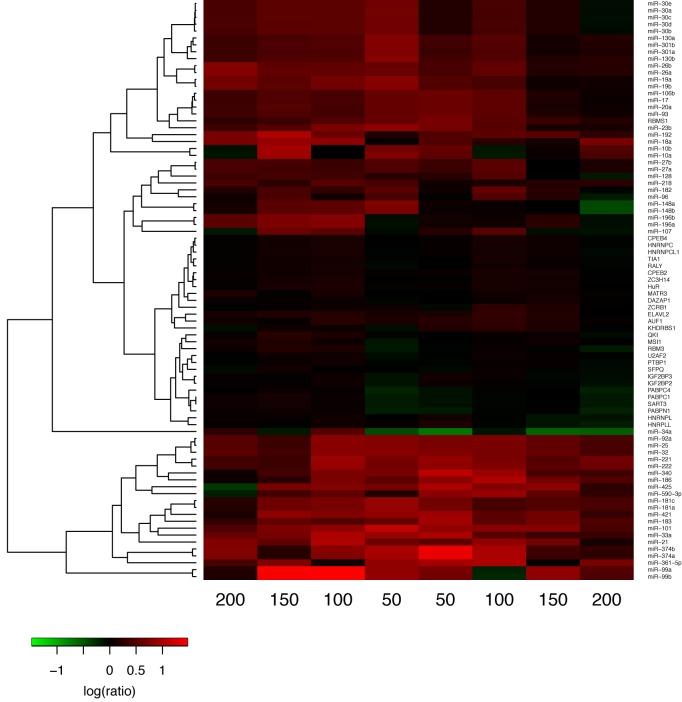
Co-occurrence of PUM1(2) sites with sites of other factors. Each row is a potential interacting factor and each column is a window. The heat map shows log-transformed enrichment ratios that are calculated as (the number of neighboring binding sites in a window/expected number of sites determined with shuffling). Minimum ratio across the three shuffle types is displayed. Row clustering is performed with hierarchical agglomerative clustering.